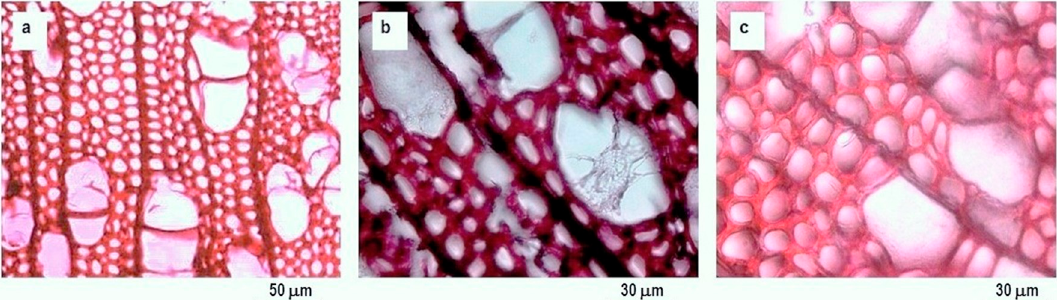
Figure 2. Optical micrographs (at 500× magnification) of the surface of poplar wood samples: ( a ) undecayed control wood sample prior to exposure to T. versicolor ; ( b ) control wood sample 30 days after exposure to T. versicolor ; and ( c ) sample treated with medium molecular weight chitosan 30 days after exposure to T. versicolor.